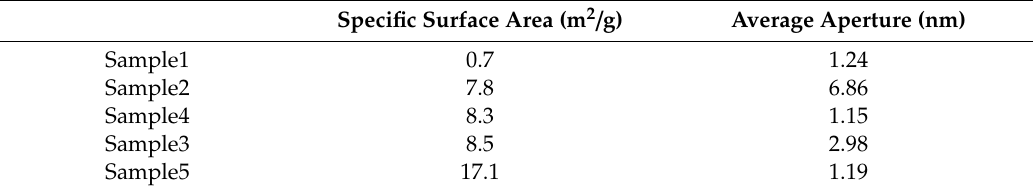
Table 2. BET characterization of rare earth concentrates under di ff erent